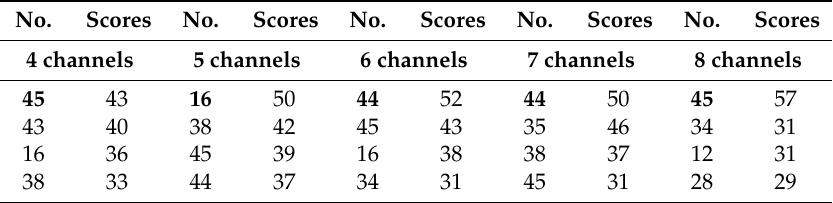
Table 6. Cumulative scores of the four best-performed filter sets under CIE standard illuminant A.